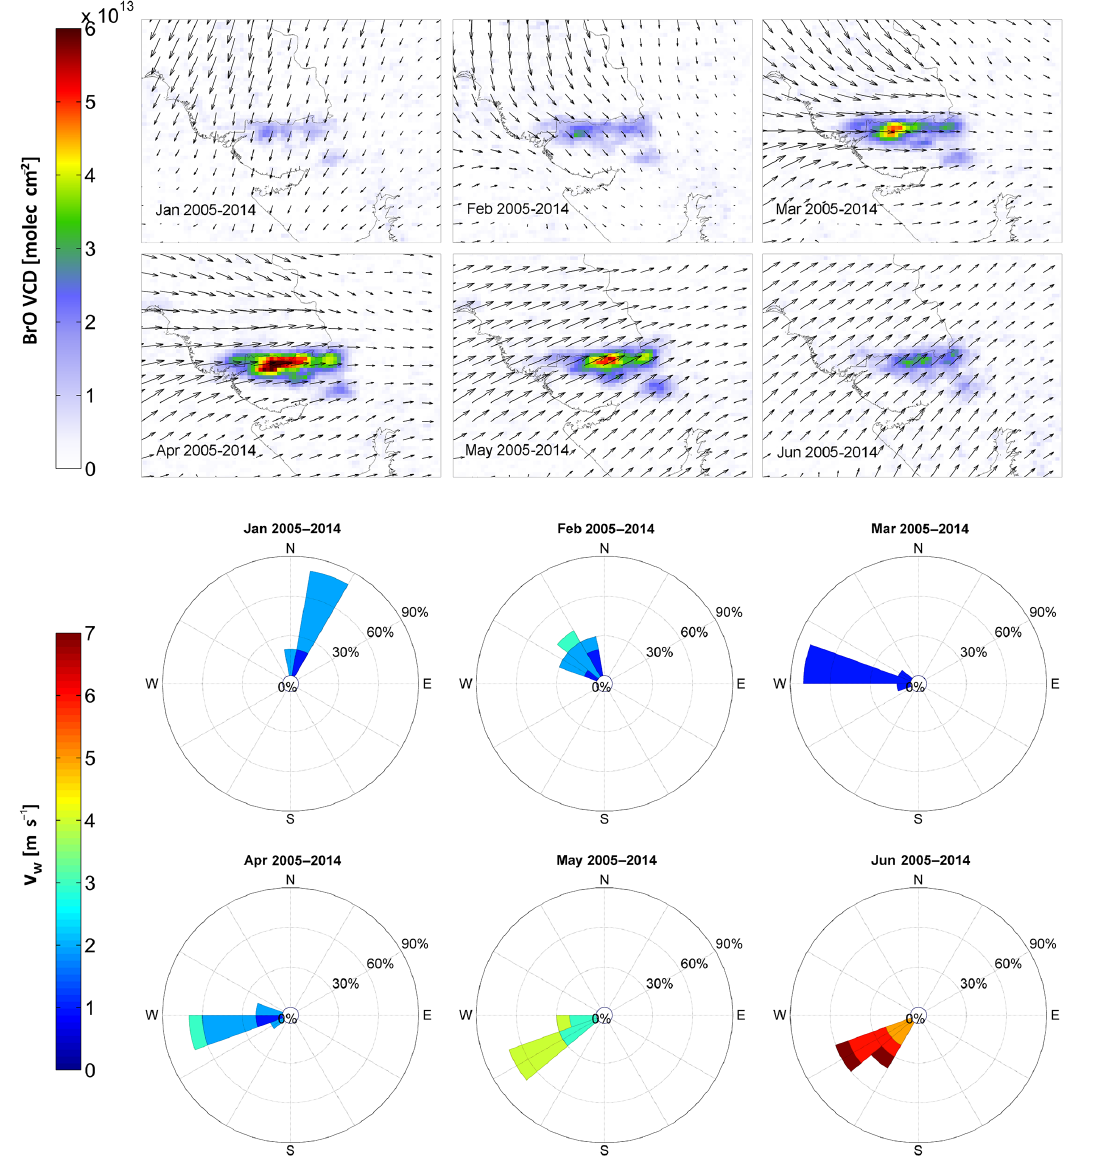
Figure 7. Mean wind field at 10m altitude over the Rann of Kutch for the time around the OMI overpass (09:00UTC) during January– June 2005–2014 according to ECMWF data together with the BrO VCDs observed from OMI (upper panel). The area is mainly affected by westerly winds at times when BrO VCDs are high. A shift in the BrO distribution in May can be explained by a turning of the main wind direction (and increasing velocity) towards northeast. Corresponding wind speeds (lower panels) are rather low (1–3ms − 1 ) before they increase with the onset of the monsoon season ( > 7ms − 1